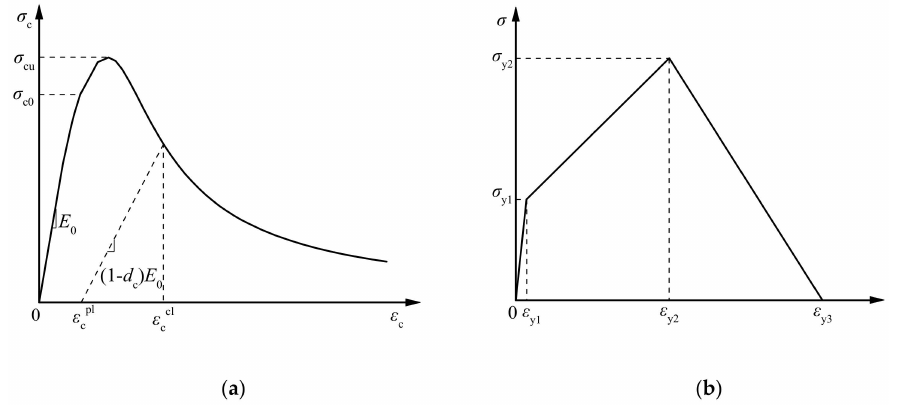
Figure 3. Equivalent plastic damage constitutive relation of concrete. ( a ) Stress–strain curve of con- crete under uniaxial compression, ( b ) stress–strain curve of equivalent material under uniaxial tensile.